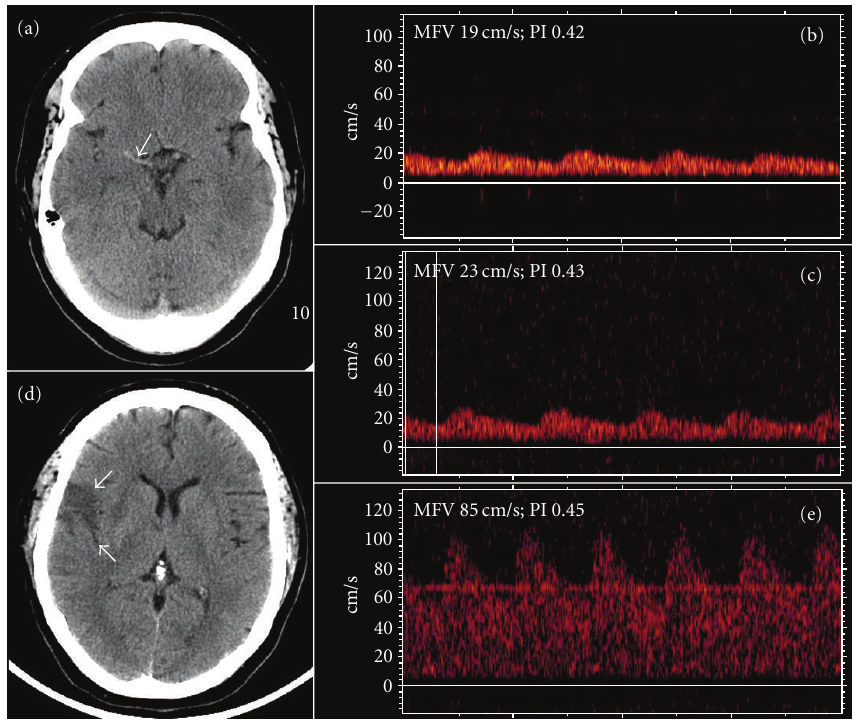
Figure 1: (a) Baseline noncontrast CT: a long thromboembolus within the right MCA trunk (arrow). (b) Baseline TCD: flattened systolic flow acceleration (TIBI 2) at a depth of 48 mm, indicating right proximal MCA occlusion. (c) One-hour TCD: improved flow velocities/waveforms (TIBI 2) at a depth of 58mm suggestive of slow and partial recanalization. (d) Followup CT reveals a small cortical infarction (arrows). (e) 24-hour TCD: normal flow velocities and waveforms (TIBI 5) at a depth of